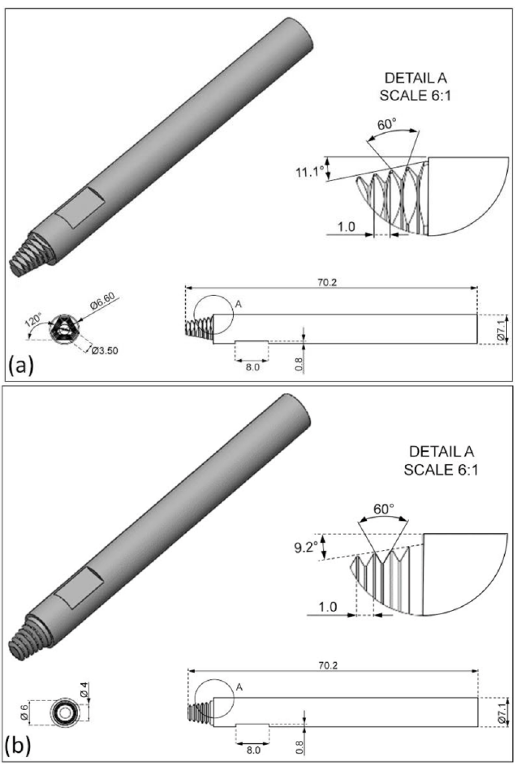
Figure 2. Schematic sketch of the tool probes employed: (a) probe 1, (b) probe